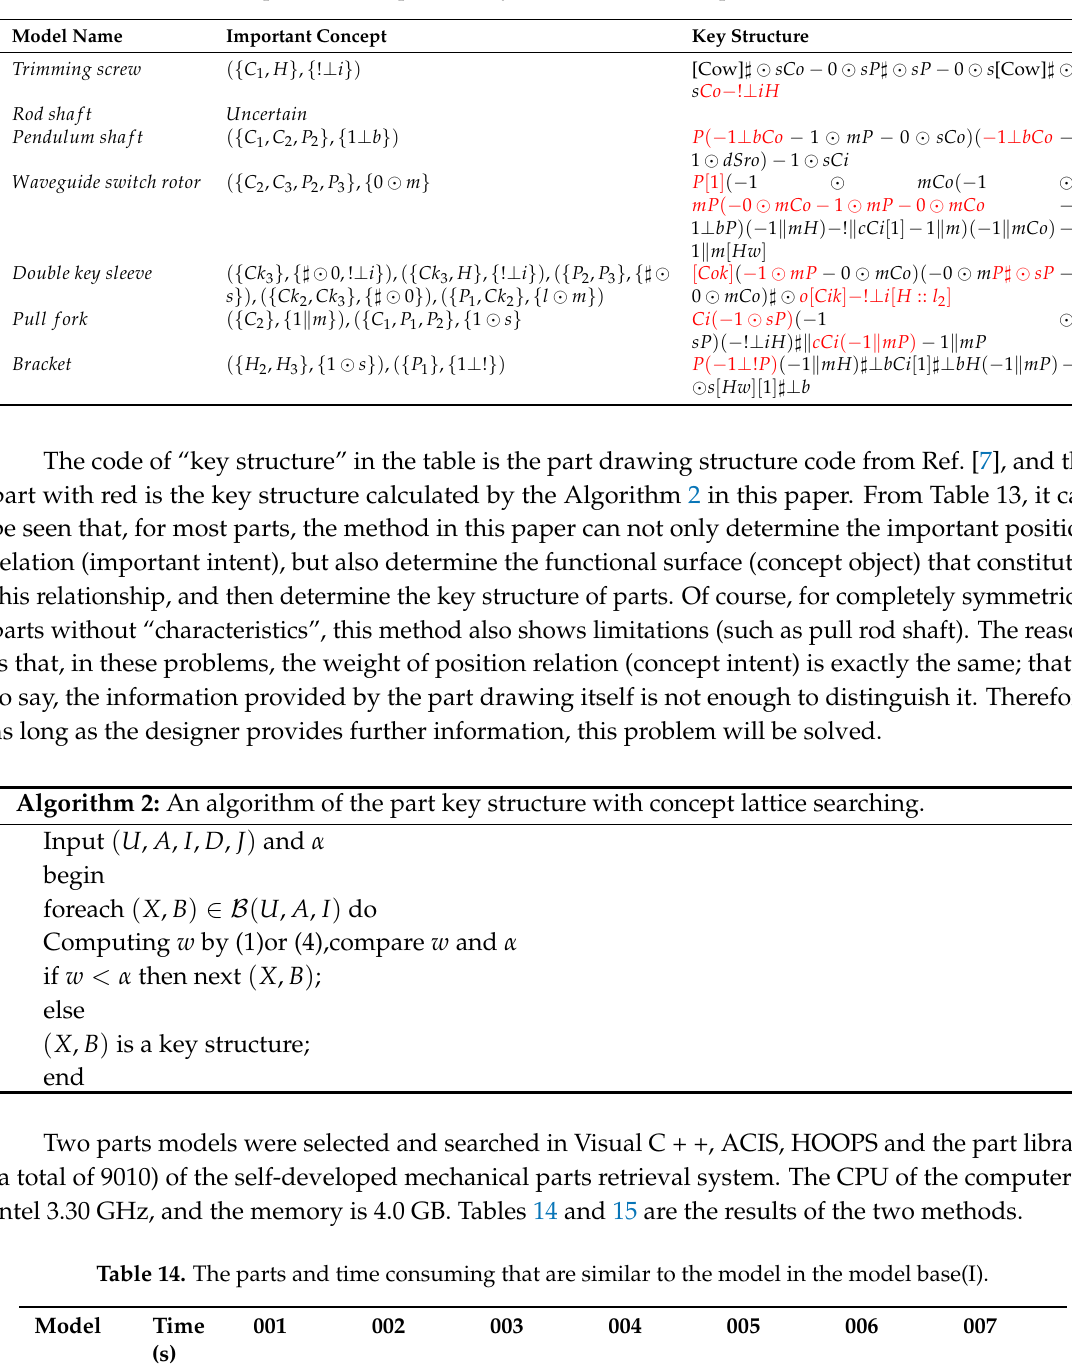
Table 13. Important concepts and key structures of the 3D parts structural model.